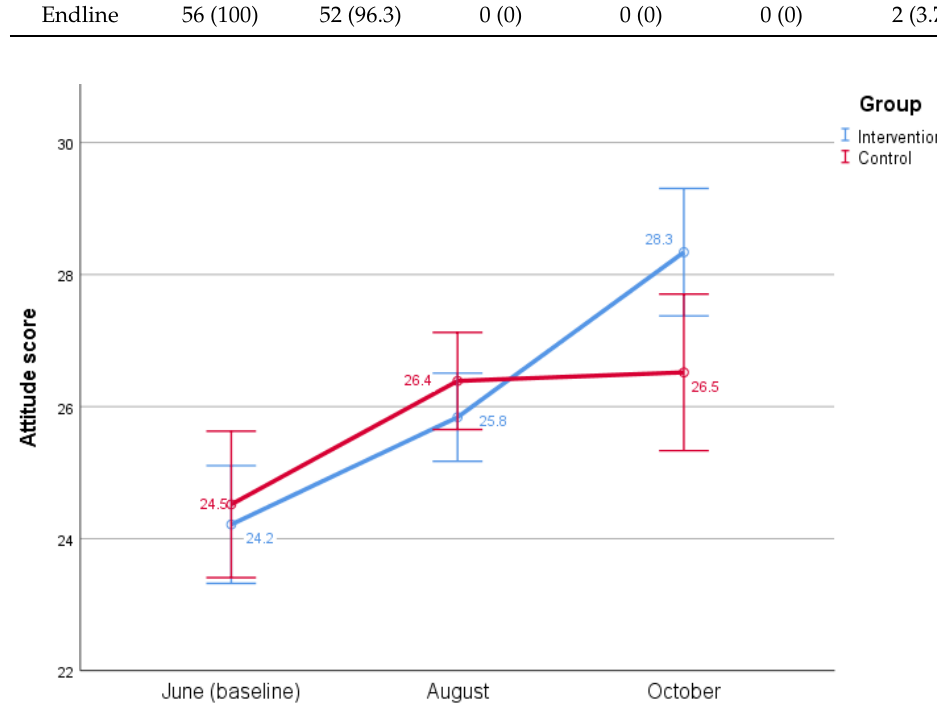
Figure 2. Change in mean dengue attitude scores during three different times in 2020 in two low- income communities in Islamabad. Maximum attitude score was 32.